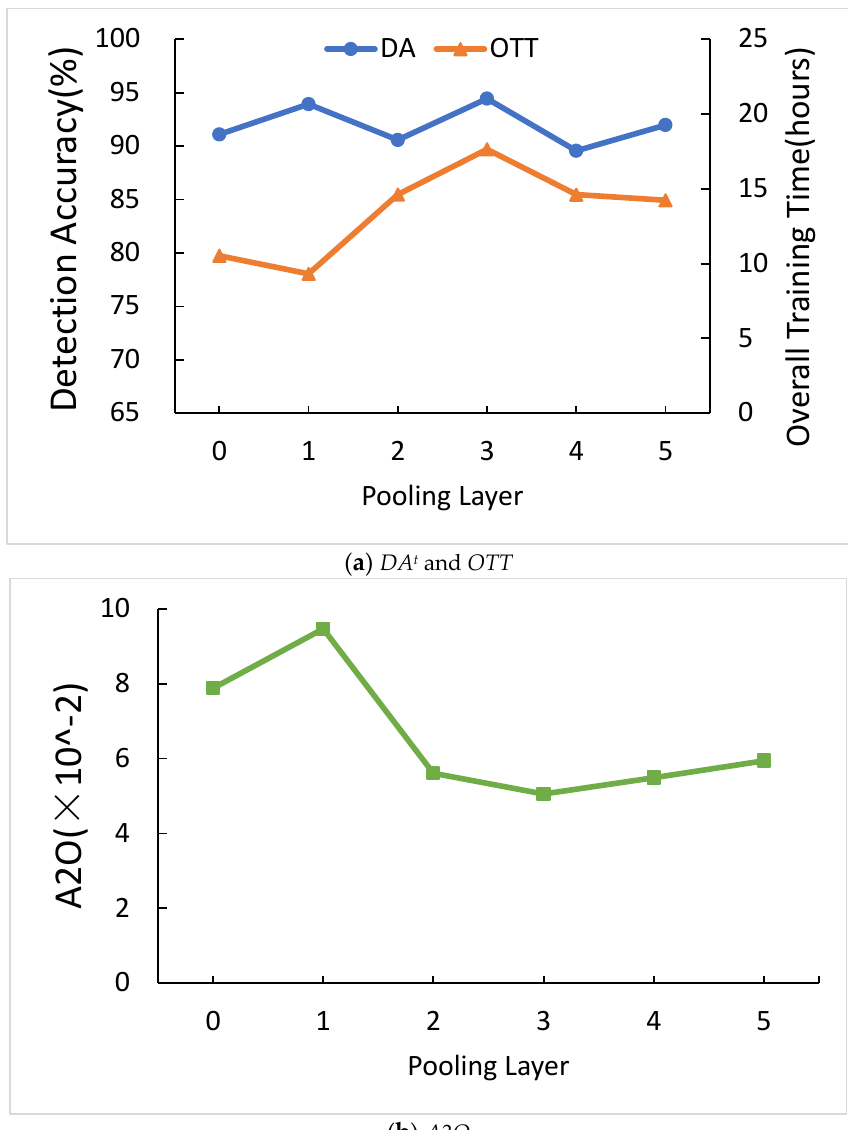
Figure 11. Comparison of the number of pooling layers.